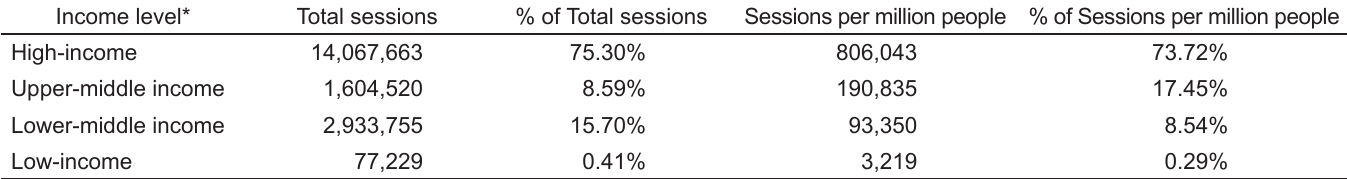
Table 2. Distribution of FOAM sessions by World Bank income level, 2016.